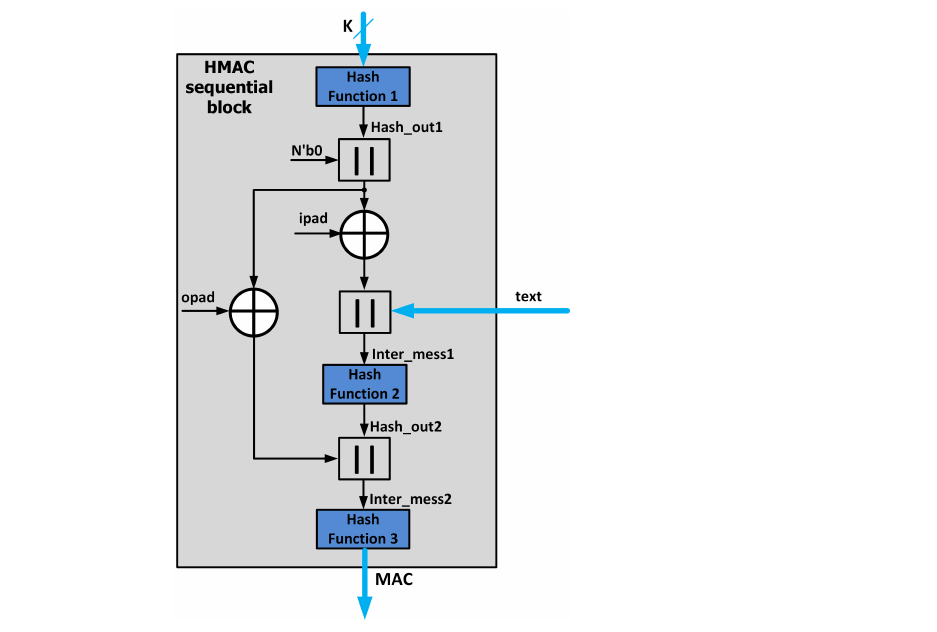
Figure 7. The conventional hardware architecture of HMAC when K > B.